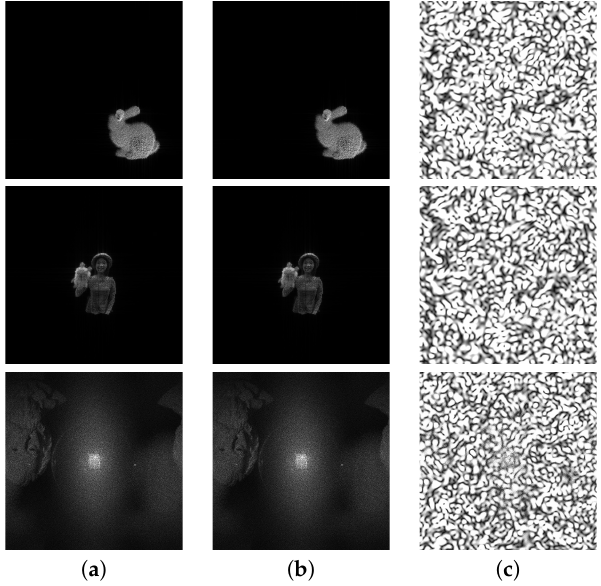
Figure 11. Examples of reconstructed images after encryption at the diffraction distance of 20 m: for the images of the Rabbit (class 1) ( a – d ), Sujin (class 2) ( e – h ), Baby (class 3) ( i – l ), and Billiard (class 4) ( m – p ); the unencrypted image ( a , e , i , m ); scaling factor 2.5 ( b , f , j , n ), 3.5 ( c , g , k , o ), and 5 ( d , h , l , p ).